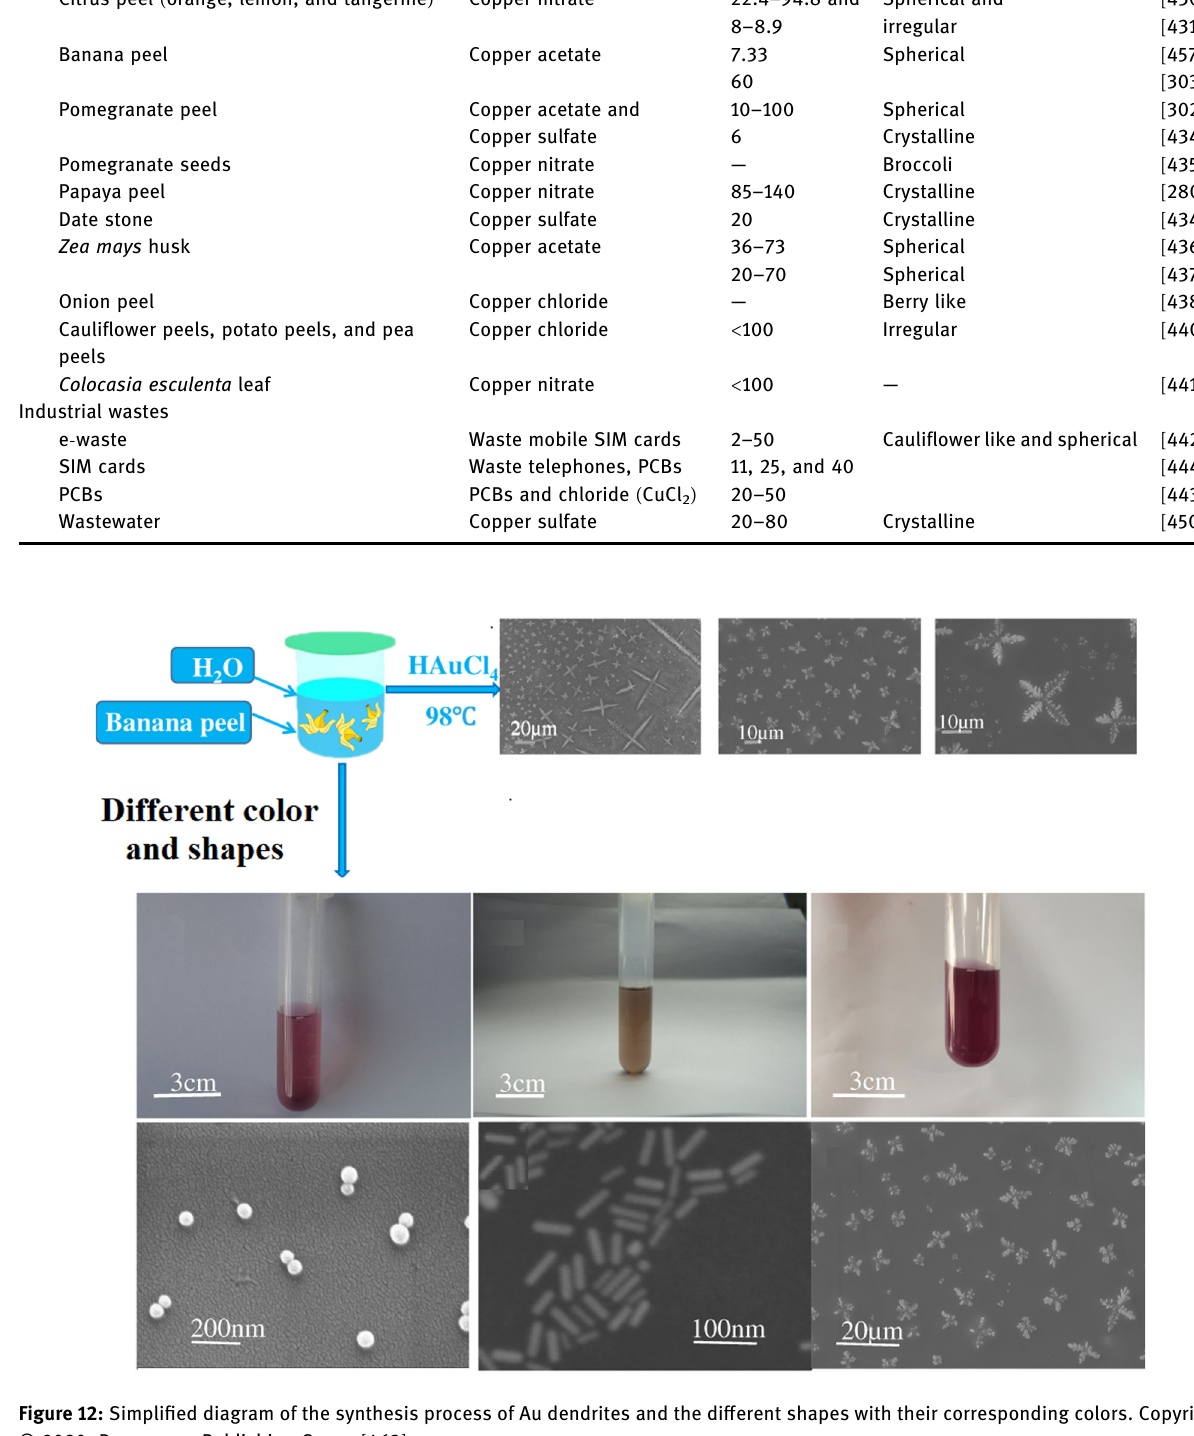
Figure 12: Simpli fi ed diagram of the synthesis process of Au dendrites and the di ff erent shapes with their corresponding colors.